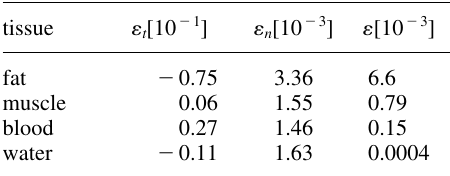
Table 3. Typical values for the coefficients in Equation (9) at 37 °